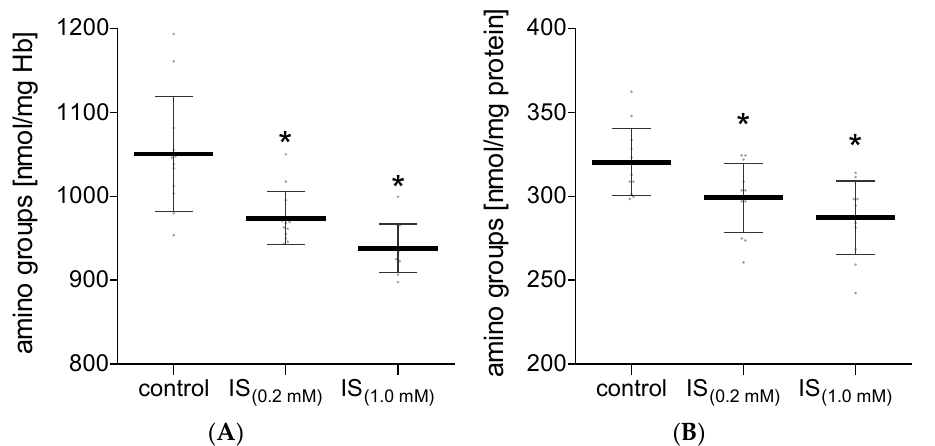
Figure 2. The levels of the free amino groups in hemolysate ( A ) and plasma ( B ) after incubation with IS. Data are expressed as mean ± standard deviation, n = 12, * p < 0.05—IS (0.2 mM) and IS (1.0 mM) vs. control. Gray spots: values of single results.